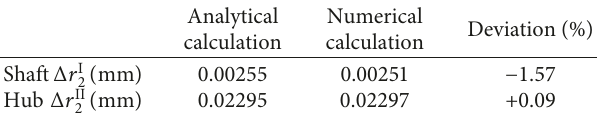
Table 1: Radial stress comparison. Table 2: Circumferential stress (tangential) comparison. Analytical Numerical Radius Deviation (%) calculation calculation Table 3: Radial displacements comparison.